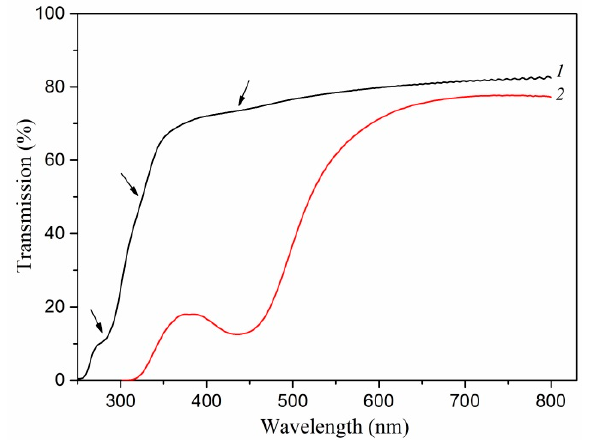
Figure 9. Transmission spectra of Ag/PAN nanocomposites, obtained at: 1 —40 wt.% AgNO 3 and 0 wt.% PI, 2 —20 wt.% AgNO 3 and 15 wt.% PI.